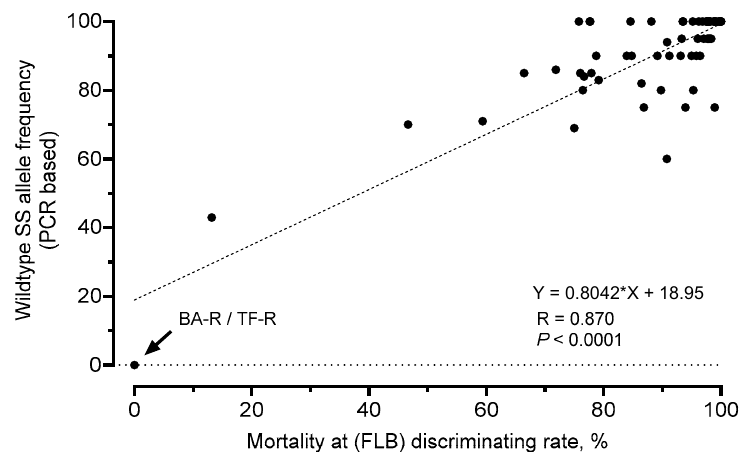
Figure 5. Relationship between diamide efficacy and resistance allele frequency in Spodoptera frugiperda . Linear regression analysis revealed a significant correlation (F = 188, df = 1, 60, p < 0.0001) between ryanodine receptor resistance allele frequency (M4790 and K4790) and survival of field- collected fall armyworm populations at a discriminating rate of flubendiamide (FLB; diet-overlay assay, 0.41 μ g a.i./cm 2 ).